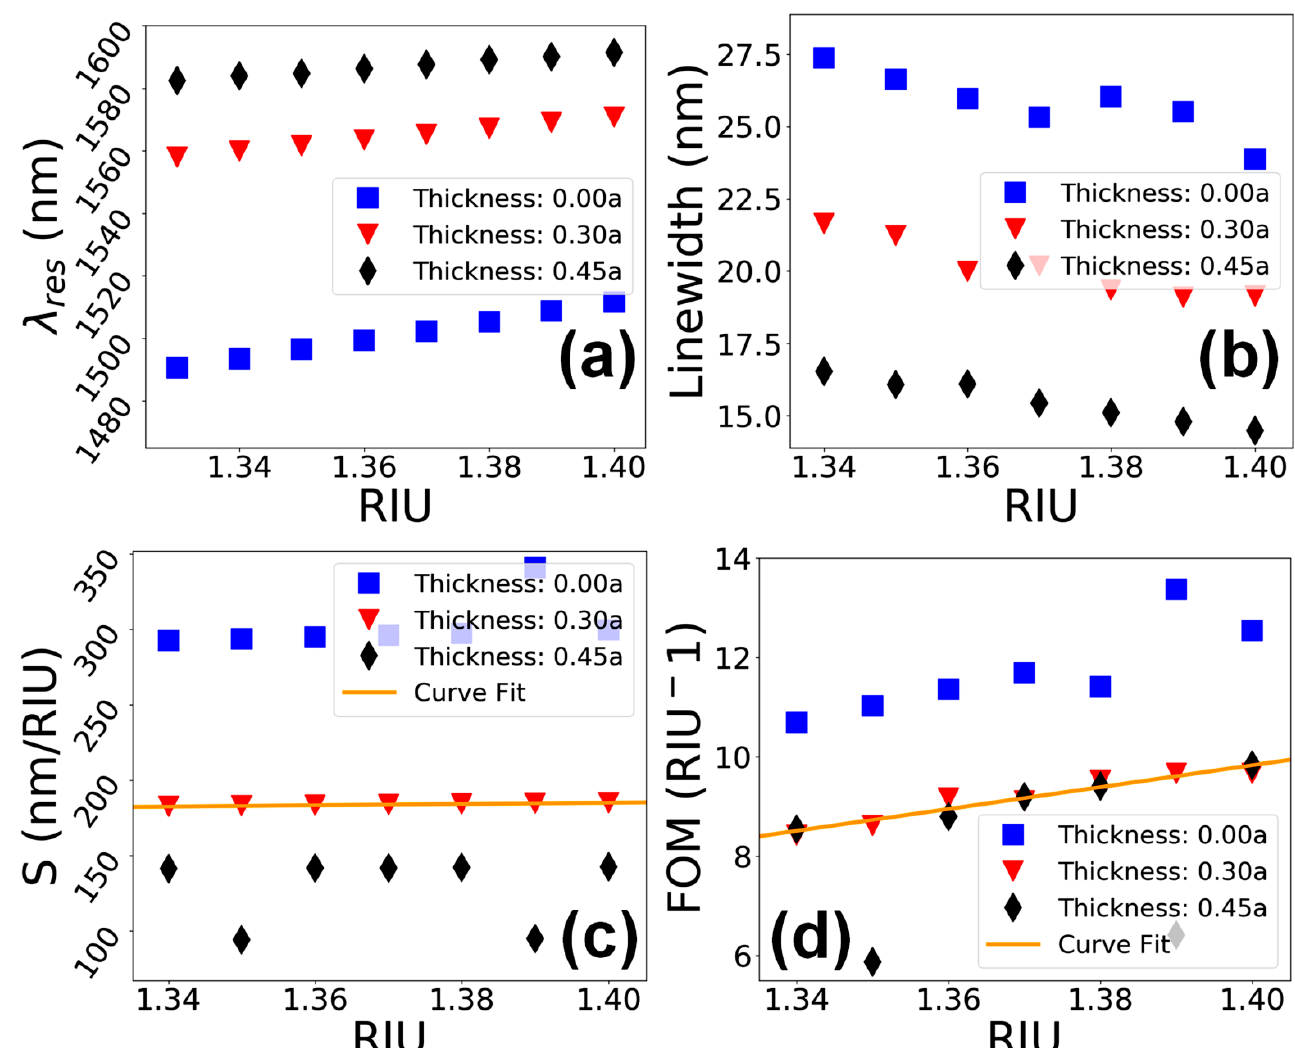
Figure 12. Performance evaluation of the sensor device vs. variation in the thickness of the cladding layer. ( a ) λ res vs. RIU. ( b ) Linewidth vs. RIU. ( c ) S vs. RIU. ( d ) FOM vs. RIU.